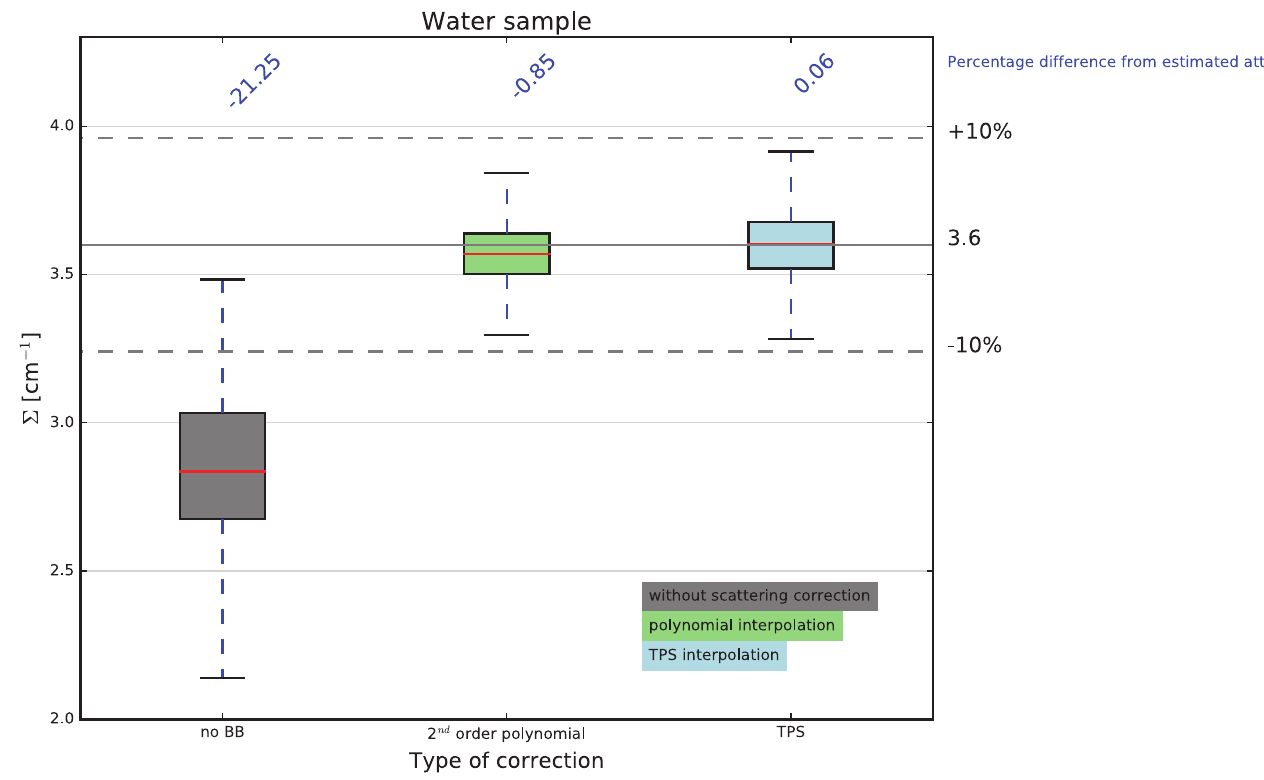
Fig 5. Effect of different interpolation scheme on the attenuation coefficients for the water